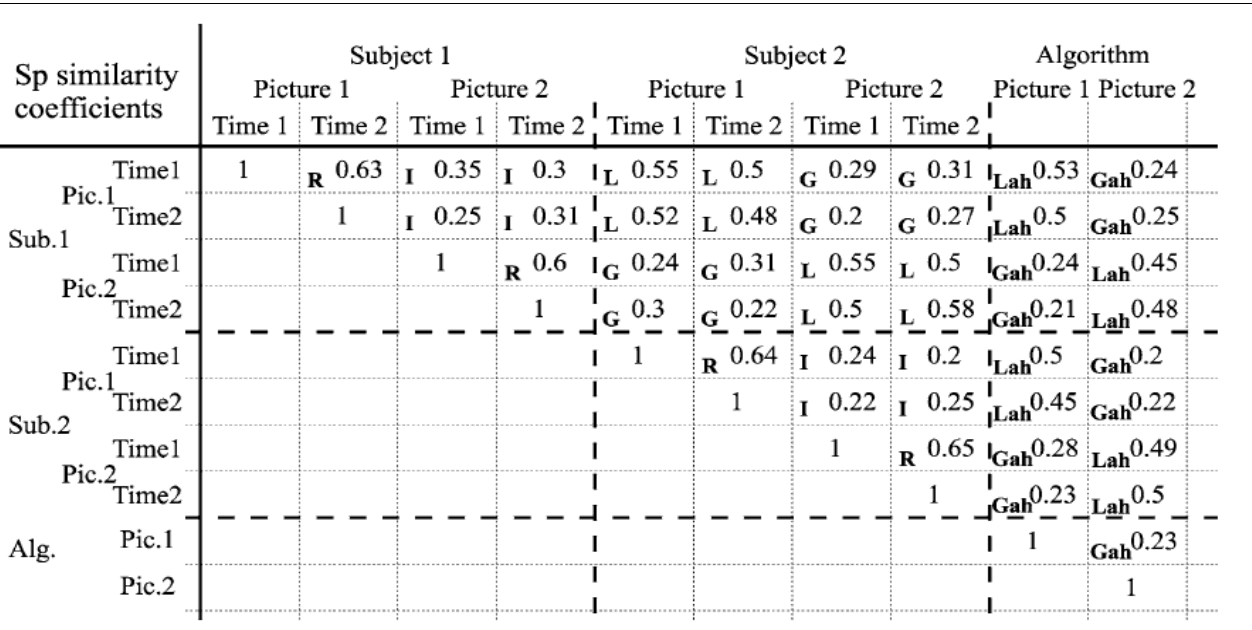
Table 1: Y-matrix